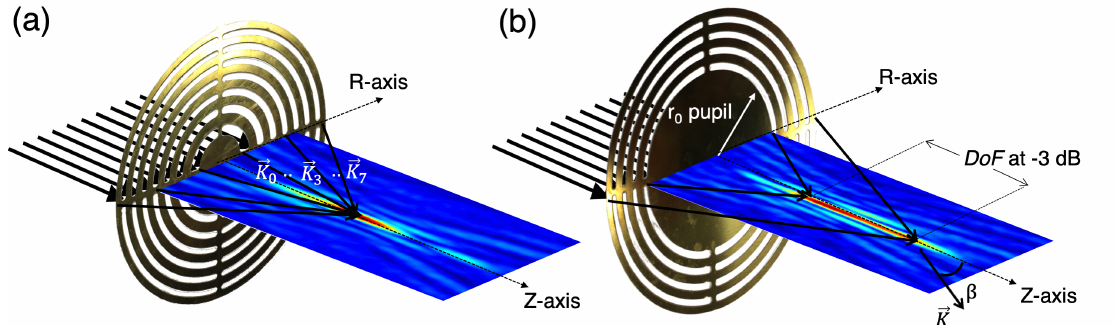
Figure 3. Beam formation scheme of ( a ) SZP and ( b )